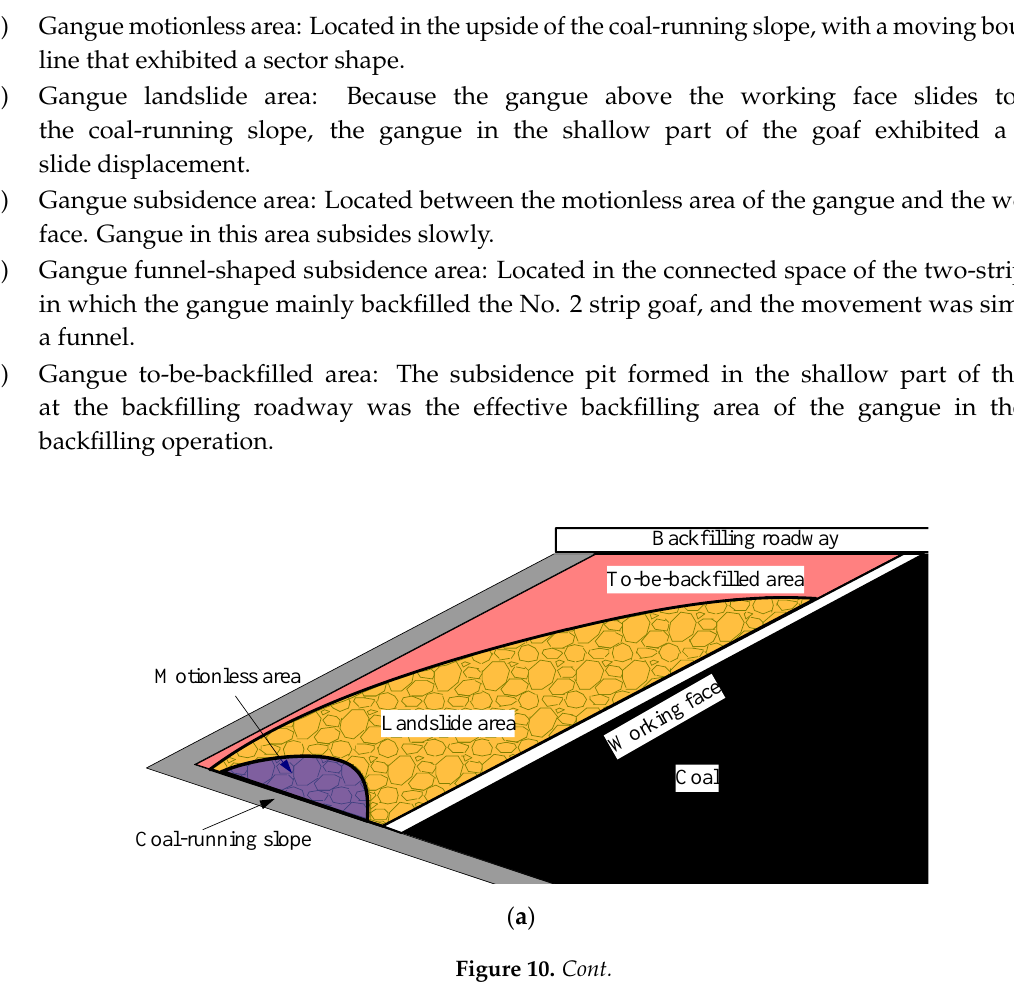
Figure 9. Gangue backfilling characteristics at the large-scale subsidence stage: ( a ) backfilling form and ( b ) displacement distribution.